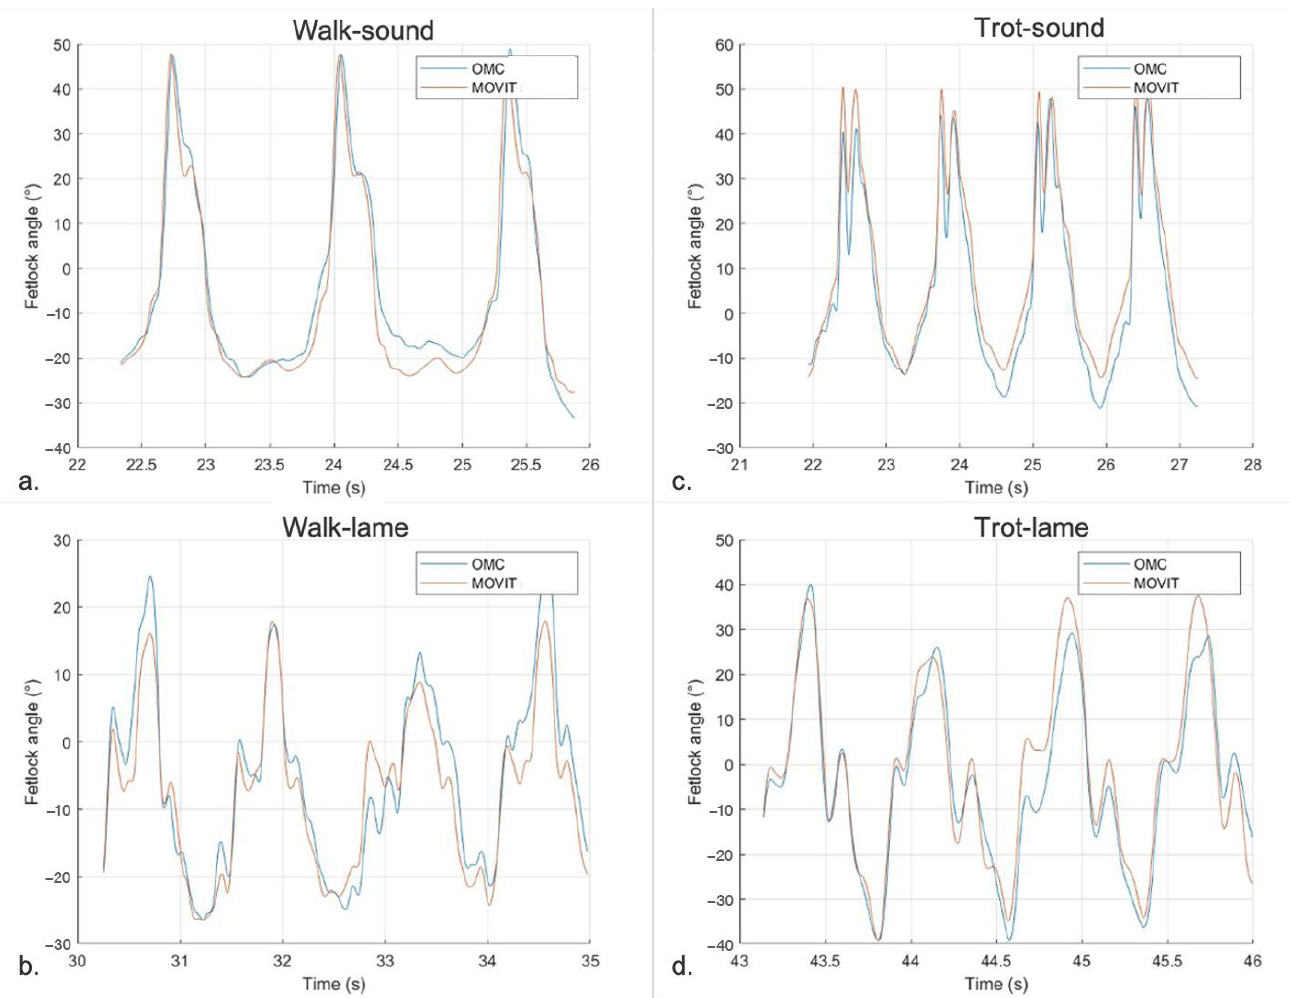
Figure 9. Pattern of FJA over time measured by the MOVIT IMU system (MOVIT-orange) and the 2-D OMC (OMC-blue) in four selected cases. ( a ) Left hind at walk in a sound horse (RMSE = 7.09° — PCC = 0.96). ( b ) Left front at walk in a lame horse (z2-RMSE = 4.69° — PCC = 0.95). ( c ) Right front at trot in a sound horse (RMSE = 7.47° — PCC = 0.97). ( d ) Left front at trot in a lame horse (z2-RMSE = 5.91° — PCC = 0.96).